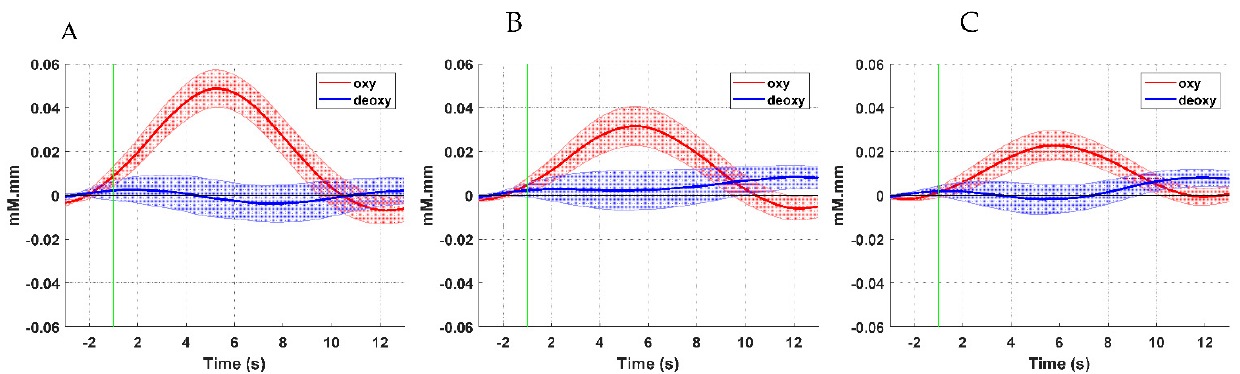
Figure 7. Time course of the averaged oxyHb and deoxyHb of the selected channels with respect to the motor cortex areas during left ankle joint movement: ( A ) RPMCdr, ( B ) RPMCvr, and ( C ) RPMA.